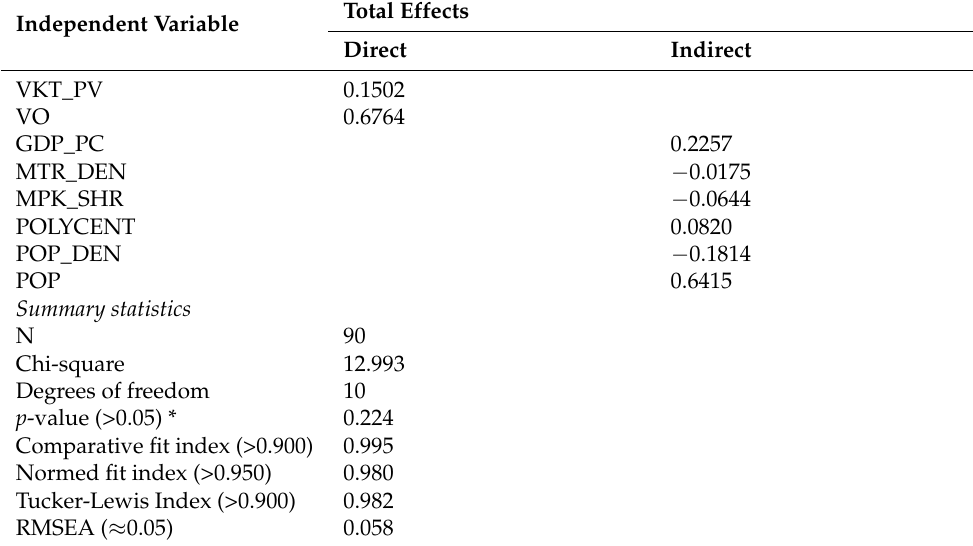
Table 3. Direct, indirect, and total effects on road traffic carbon emissions, measured in